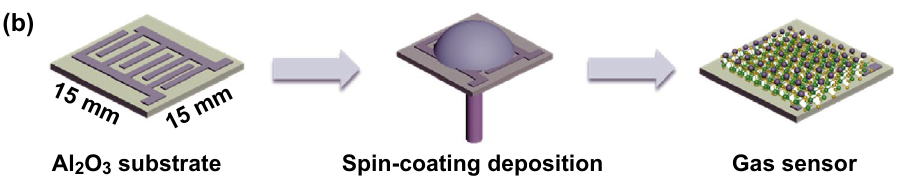
Fig. 1 Schematic illustration of a formation of the MoS 2 nanosheets and QD‑sensitized MoS 2 nanosheets and b fabricated process diagram of the sensitized structure‑based gas